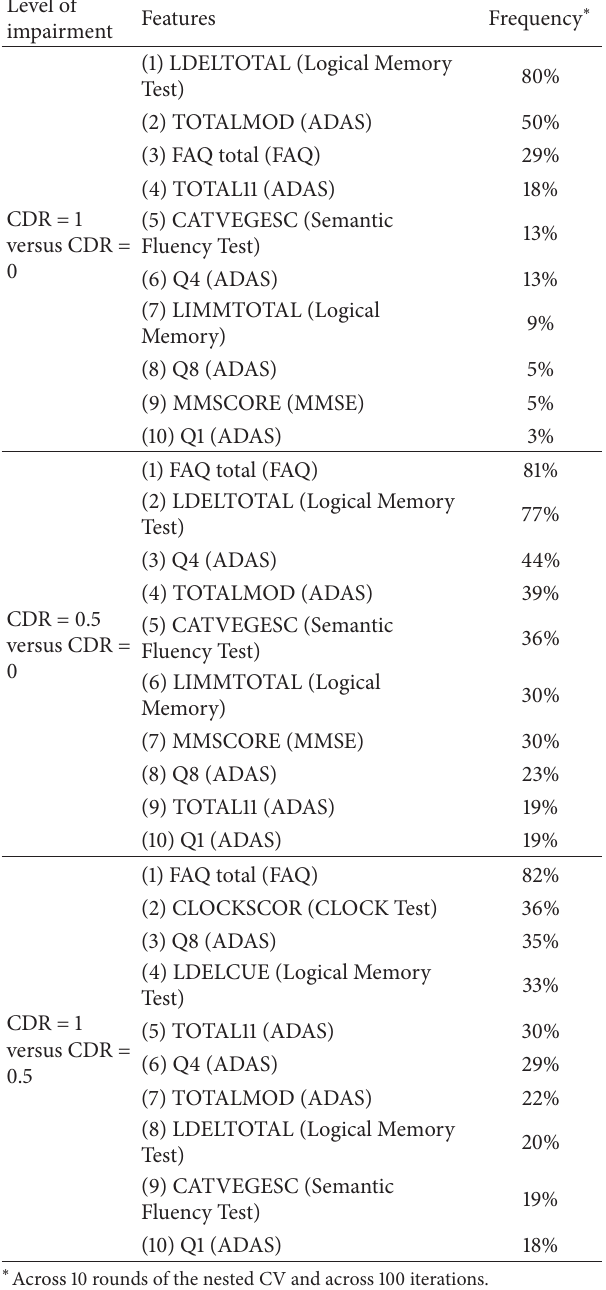
Table 10: Top 10 features most frequently found as best predictors across all 10 rounds and all 100 iterations using the features chosen by the